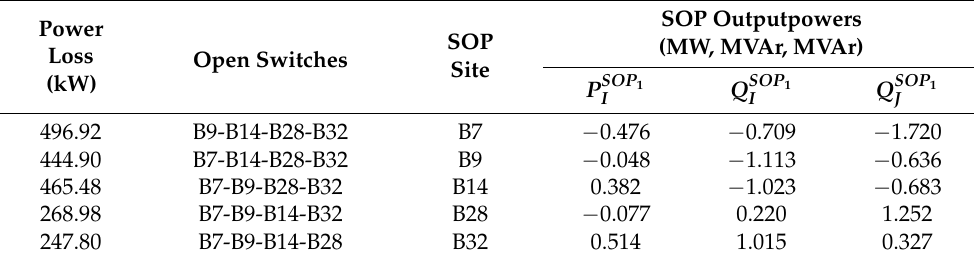
Table 4. Optimal solutions from [16].